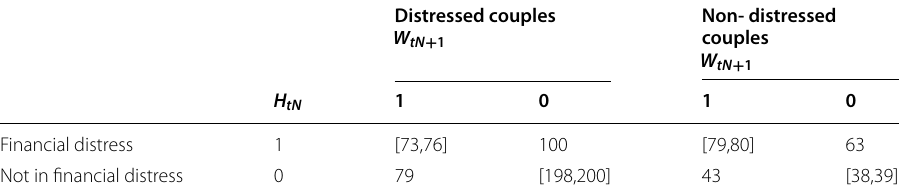
Table 3 The spouse’s behavior data with indeterminacy Distressed couples Non- distressed W tN + 1 couples W tN + 1 H tN 1 0 1 0 Financial distress 1 [73,76] 100 [79,80] 63 Not in financial distress 0 79 [198,200] 43